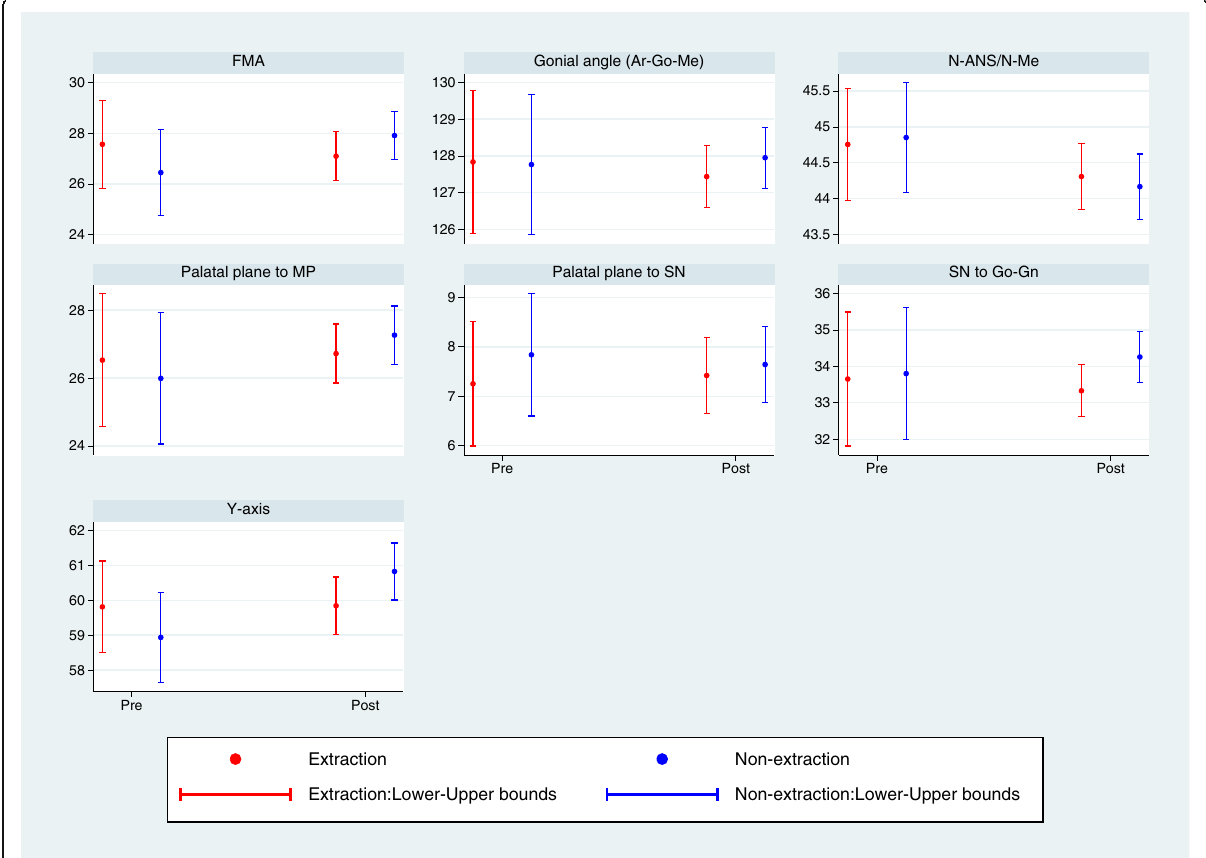
Fig. 3 Comparisons between pre- and posttreatment measurements in the extraction and non-extraction group of